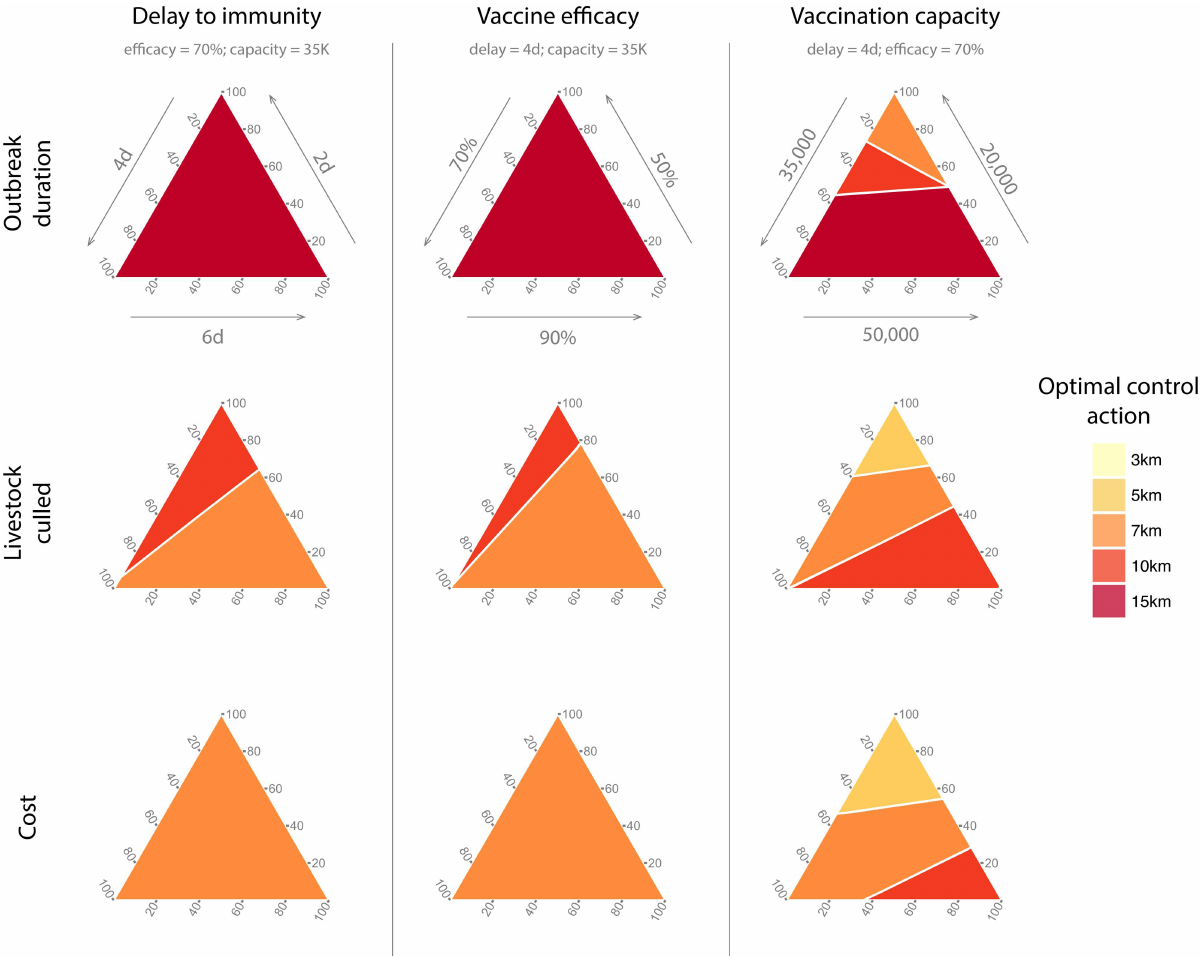
Fig 3. Ternary plots showing the control action which minimises the measureof management success shown in the respective row. Columnsrepresent the specific vaccinationassumptionthat is being varied (with the other two assumptionsfixed at intermediate values). The edges of the individualternary plots are the belief weight axes. Gridlinesfor tick marks on the beliefweight axes run between one axis and the next axis anti-clockwise. Axis labels remain the same down each column. For instance, the ternary plot in the second row and third column shows the control action that minimises the numberof livestock culledfor different belief weights associated with vaccinationcapacity (with delay to immunity fixed at 4 days, and vaccine efficacy fixed at 50%). For example,the top vertex of this plot shows that ring vaccination at 5km is optimal when the belief weight for a vaccinationcapacityof 20,000 doses per day is 100% (and zero on the other two